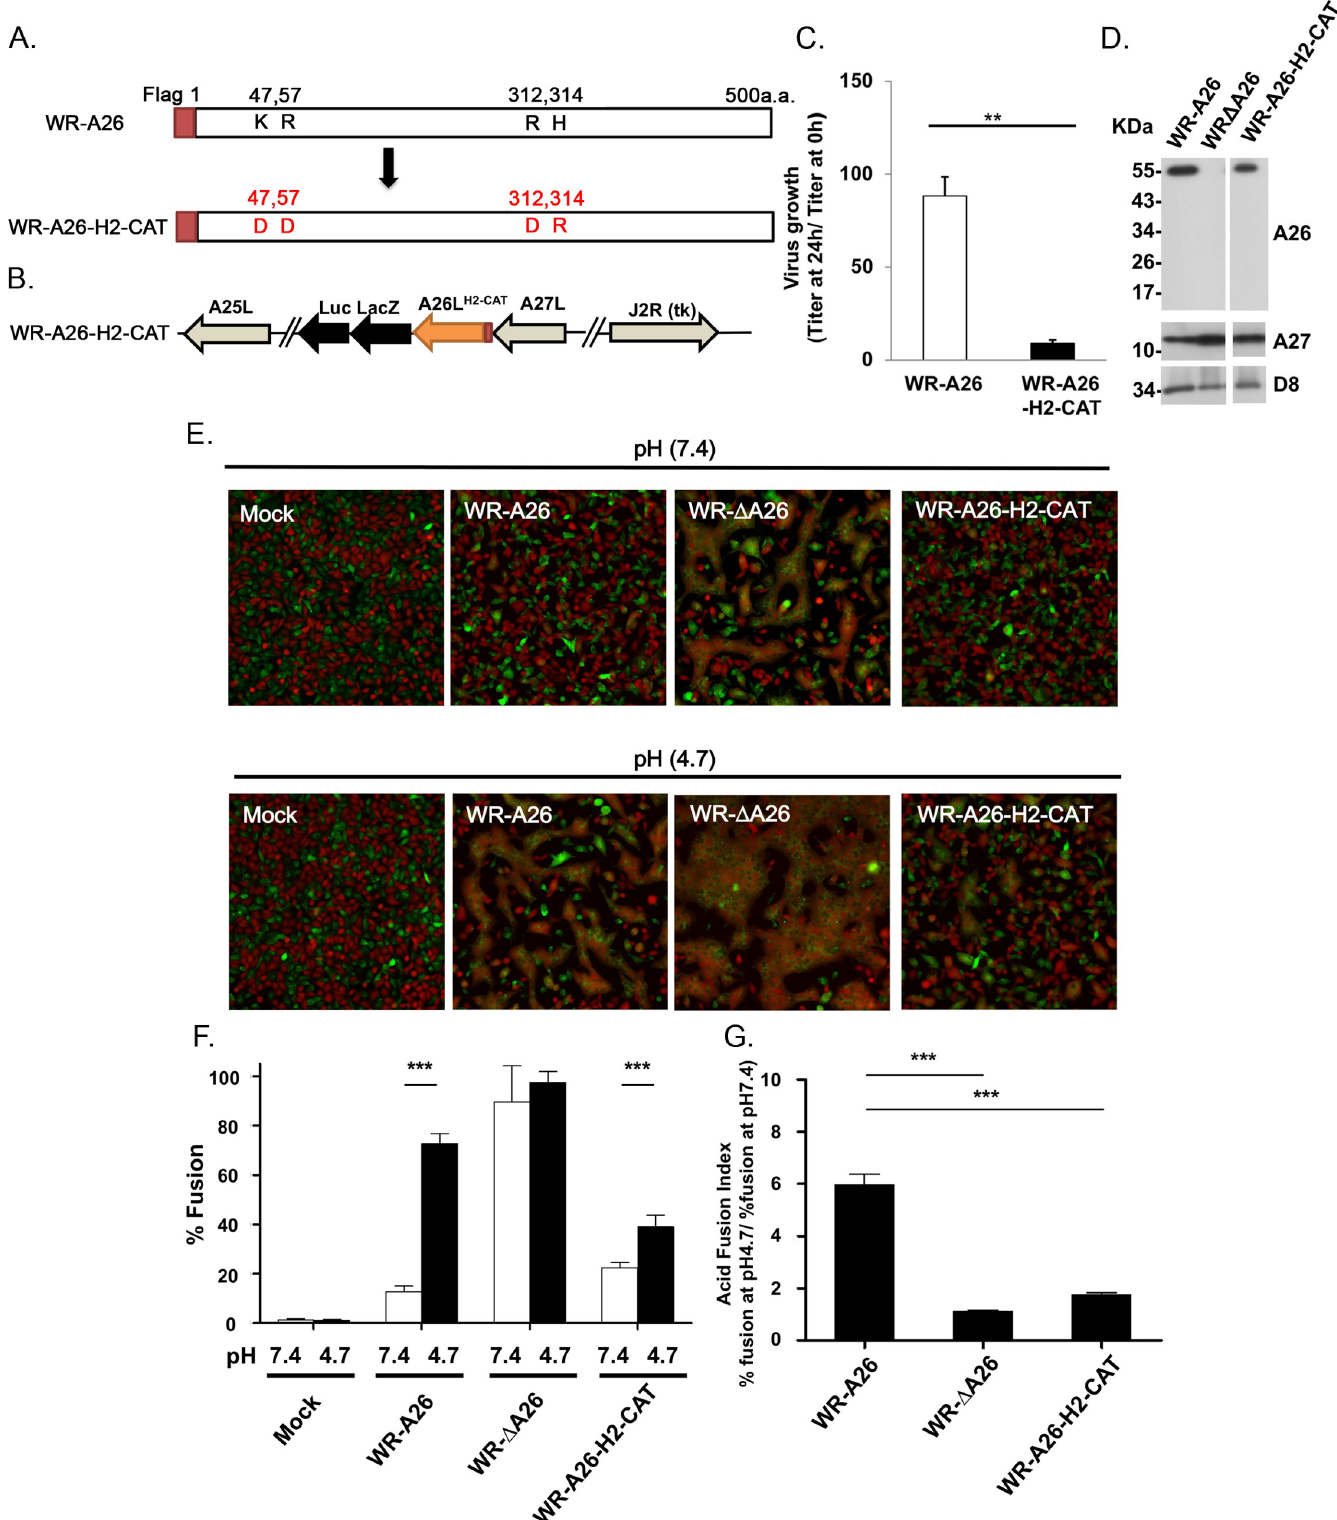
Fig 6. Generation of A26 mutant vaccinia viruses containing K47D, R57D, R312D and H314R mutations in A26 protein (A26-H2-CAT). (A). Schematic representation of full-length WR-A26 and mutant A26-H2-CAT proteins. Each construct contains flag-tag sequences at the N-terminus. (B). Genome arrangement of